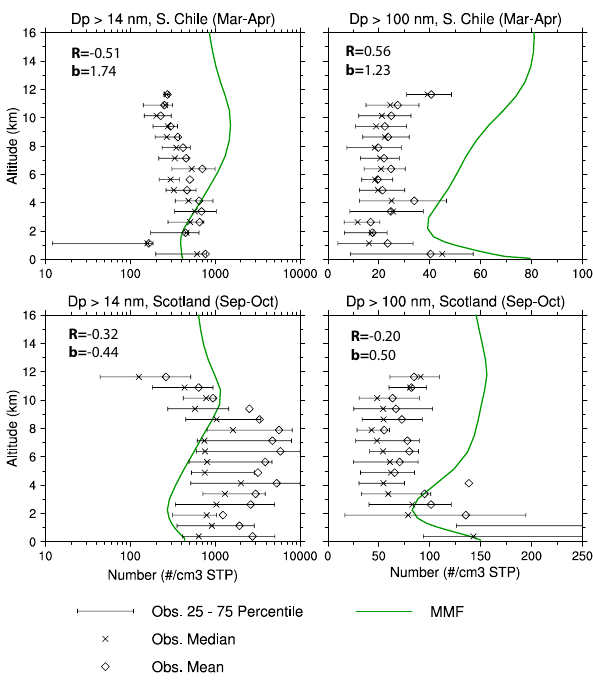
Fig. 20. Vertical profiles of the number concentration of (left) Aitken mode particles (diameter > 14nm) and (right) accumulation mode particles (diameter > 100nm) (top) over Punta Arenas, Chile, in March/April and (bottom) over Prestwick, Scotland, in Septem- ber/October. Observations are from Minikin et al. (2003): median (star), 25 and 75 percentiles (left end and right end of error bars). Model results are averaged over 60–50 ◦ S, 70–85 ◦ W for Chile, and over 50–60 ◦ N, 10 ◦ W–5 ◦ E for Scotland. Normalized model mean bias (b) and the correlation coefficient between the model and ob- servations (R) are shown in each panel. Values of b and R are calcu- lated using observed values provided at discrete altitudes and model values interpolated from model grid to those